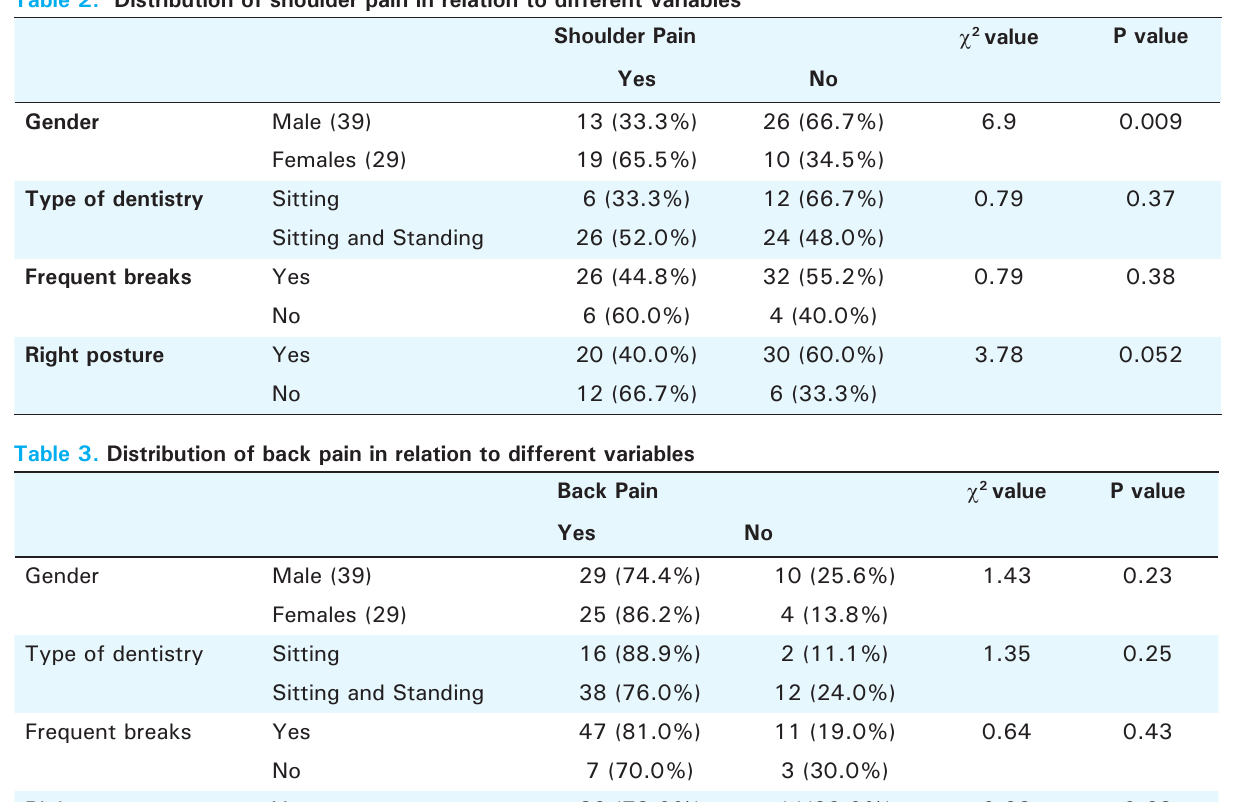
table 2. distribution of shoulder pain in relation to different variables